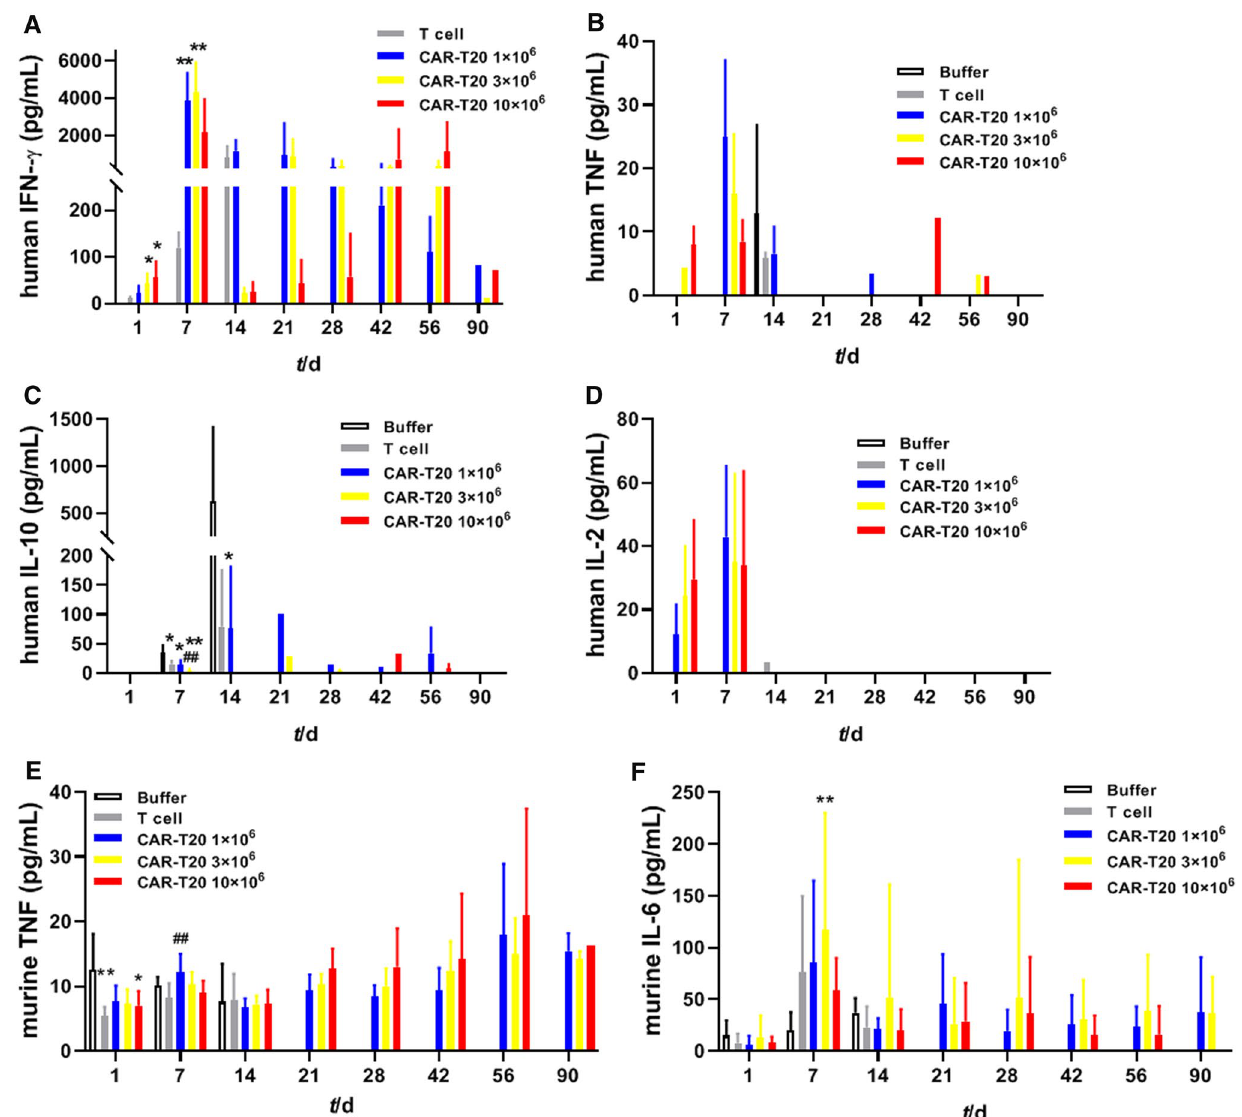
Fig. 5 Cytokine profiles in NSG mice. The levels cytokines of human IFN-γ ( A ), human TNF ( B ), human IL-10 ( C ), human IL-2 ( D ), mouse TNF ( E ), and mouse IL-6 ( F ) in animals of each group at 1, 7, 14, 21, 28, 42, 56 and 90 days post administration are demonstrated. Comparing with the Buffer group, *p < 0.05, **p < 0.01; comparing with the T cell group, ##p <